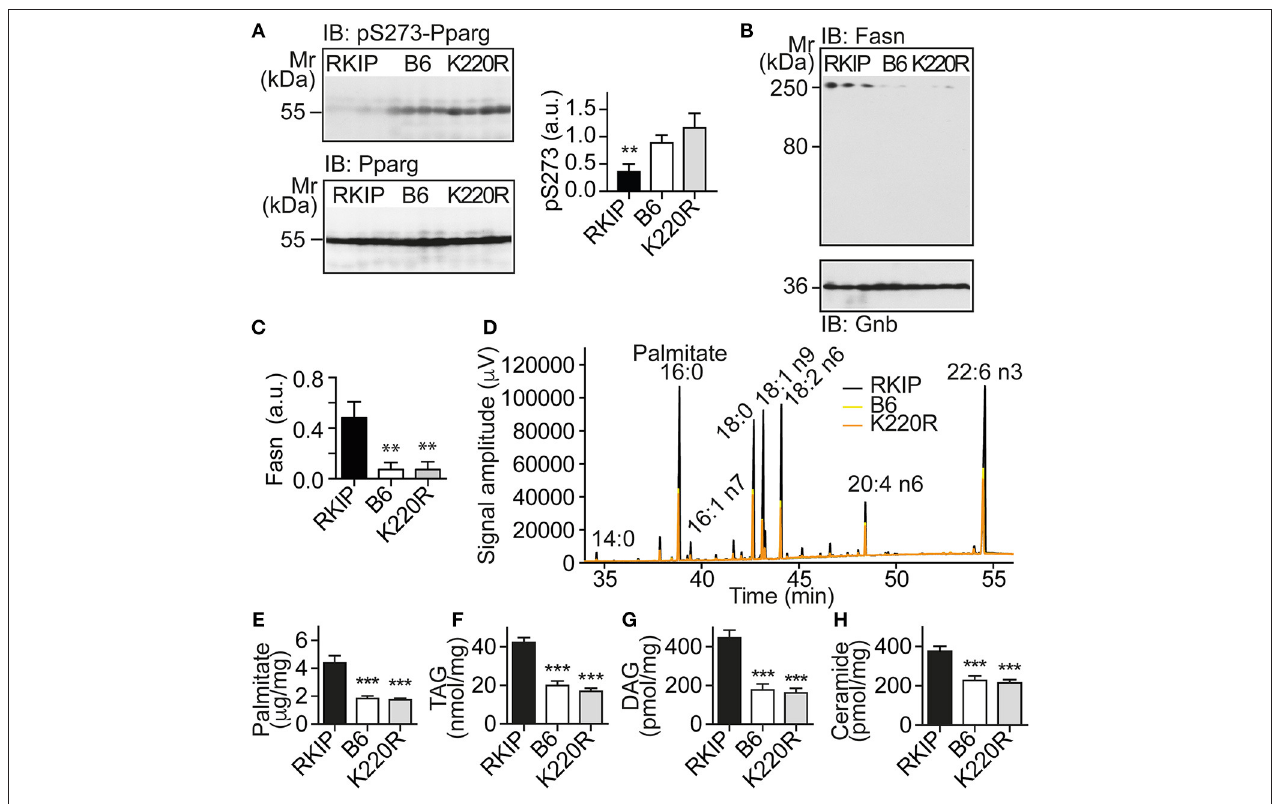
FIGURE 6 | Activation of Pparg , and cardiotoxic lipid load in Tg-RKIP but not in Tg-GRK2K220R hearts. (A) Immunoblot detection of Pparg phosphorylated on serine-273 (pS273-Pparg) in Tg-RKIP, non-transgenic B6 and Tg-GRK2K220R hearts ( ± s.d.; n = 4 hearts/group; ** p < 0.01 vs. B6 and K220R; Tukey’s test). The lower panel shows the total cardiac Pparg protein content. (B,C) Immunoblot detection of Fasn in Tg-RKIP, non-transgenic B6 and Tg-GRK2K220R hearts ( ± s.d.; n = 3 hearts/group; ** p < 0.01 vs. RKIP; Tukey’s test). (D) GC analysis of cardiac lipids of Tg-RKIP, Tg-GRK2K220R, and non-transgenic B6 hearts. (E - H) Cardiac lipid analysis detects increased cardiac contents of palmitate (E) , TAG (F) , DAG (G) , and ceramide (H) in Tg-RKIP hearts ( ± s.d.; n = 7; *** p < 0.001 vs. RKIP; Dunnett’s test). See also Supplementary Figures 5A–C